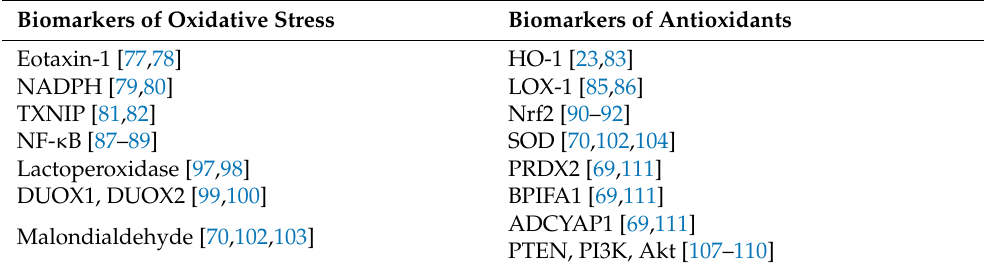
Table 4. Biomarkers of oxidative stress and antioxidants in the CRSwNP.